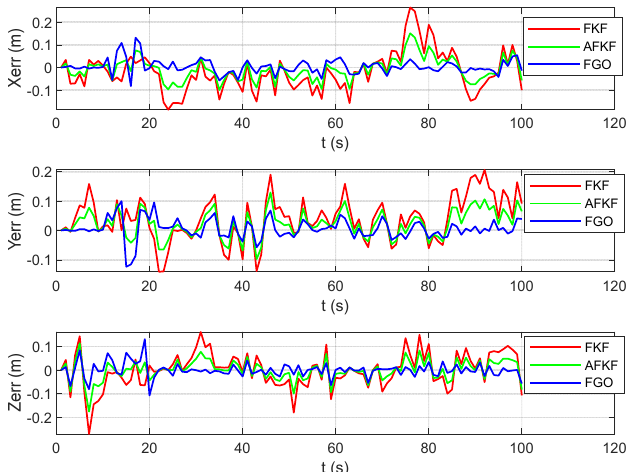
Figure 16. Comparison of position errors of different algorithms in MH_03_medium scene.